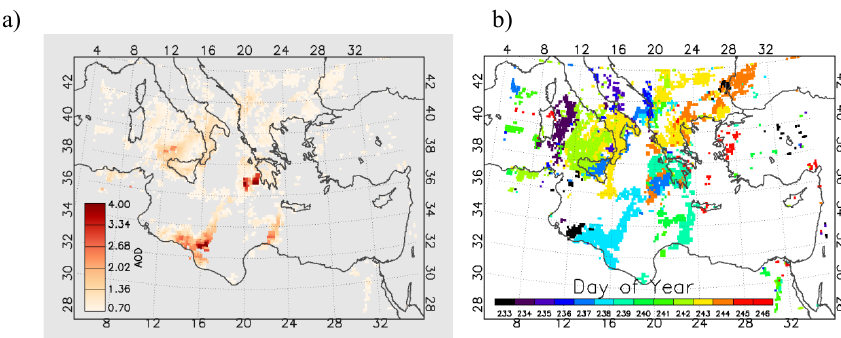
Figure 11. Data extracted for the 2007 Mediterranean mega-fire event from Terra and Aqua MODIS AOD products (a) Maximum value composite of atmospheric AOD developed using Terra and Aqua MODIS observations (MOD04 and MYD04 products) acquired between 21 August and 3 September 2007. Only pixels with an AOD value in excess of 0.7 are shown. (b) Day of the year (DOY) of the highest AOD value shown in (a) .